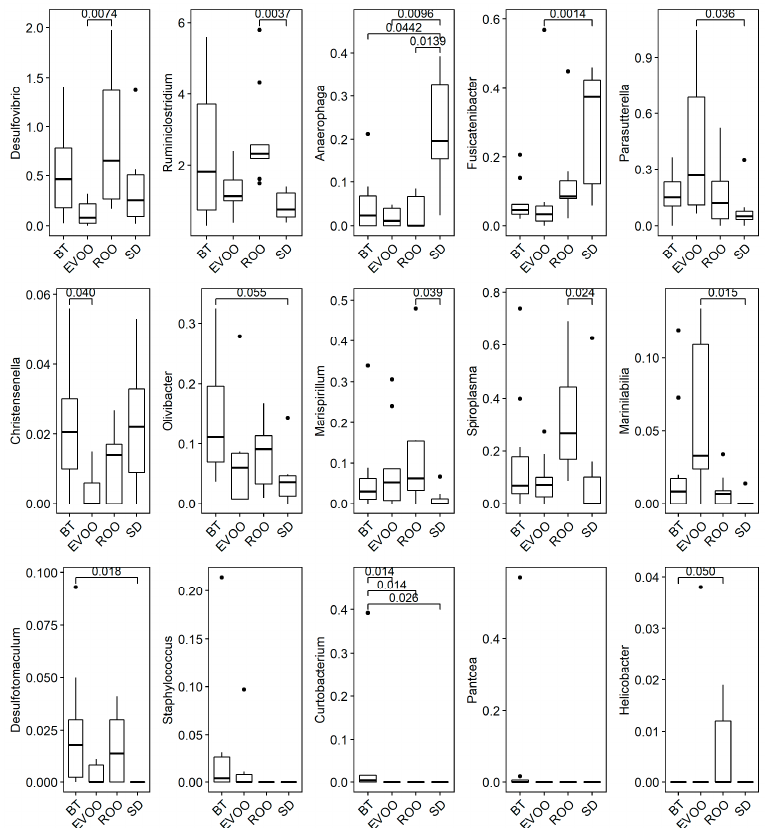
Figure 4. Box plots of presence of the fifteen genera with significant differences ( p < 0.05), in percentage of sequences, after feces DNA extraction from mice fed with the different diets. BT: butter diet; EVOO: extra virgin olive oil diet; ROO: refined olive oil diet; SD: standard chow. SD, EVOO and BT diet values from [12]. Significant pairwise comparisons adjusted p -values are also shown.